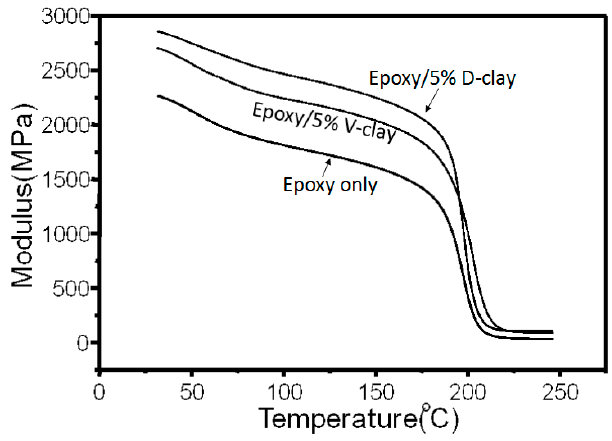
Figure 8. DMA curves of neat epoxy, epoxy with 5 wt % D-clay, 5 wt % V-clay, and 5 wt % organoclay.